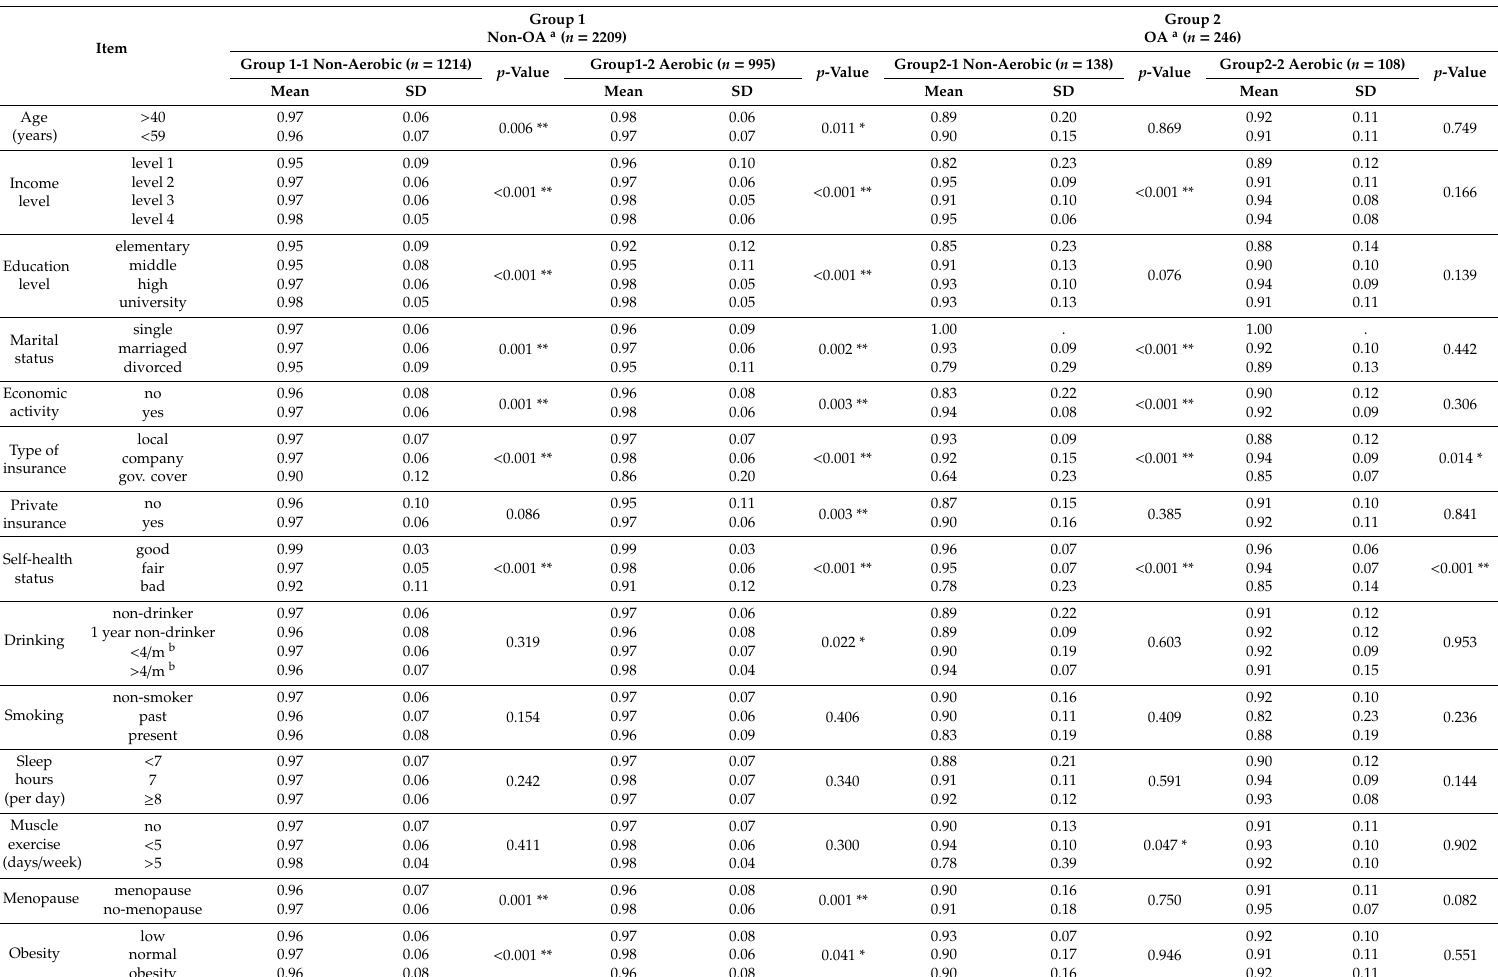
Table 2. Relationship between aerobic activity and subject characteristics in osteoarthritis and